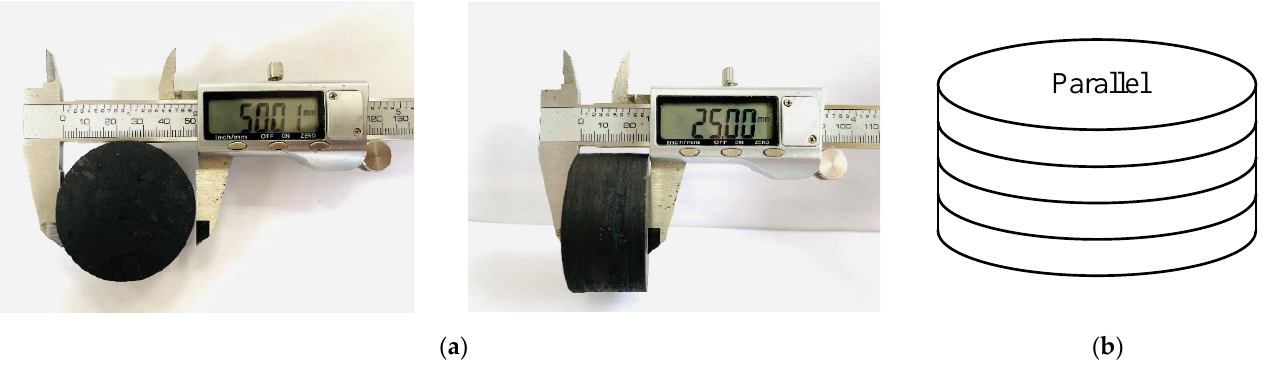
Figure 2. Coal specimens: ( a ) the length and diameter of the specimens. ( b ) the schematic diagram of the coal bedding directivity.